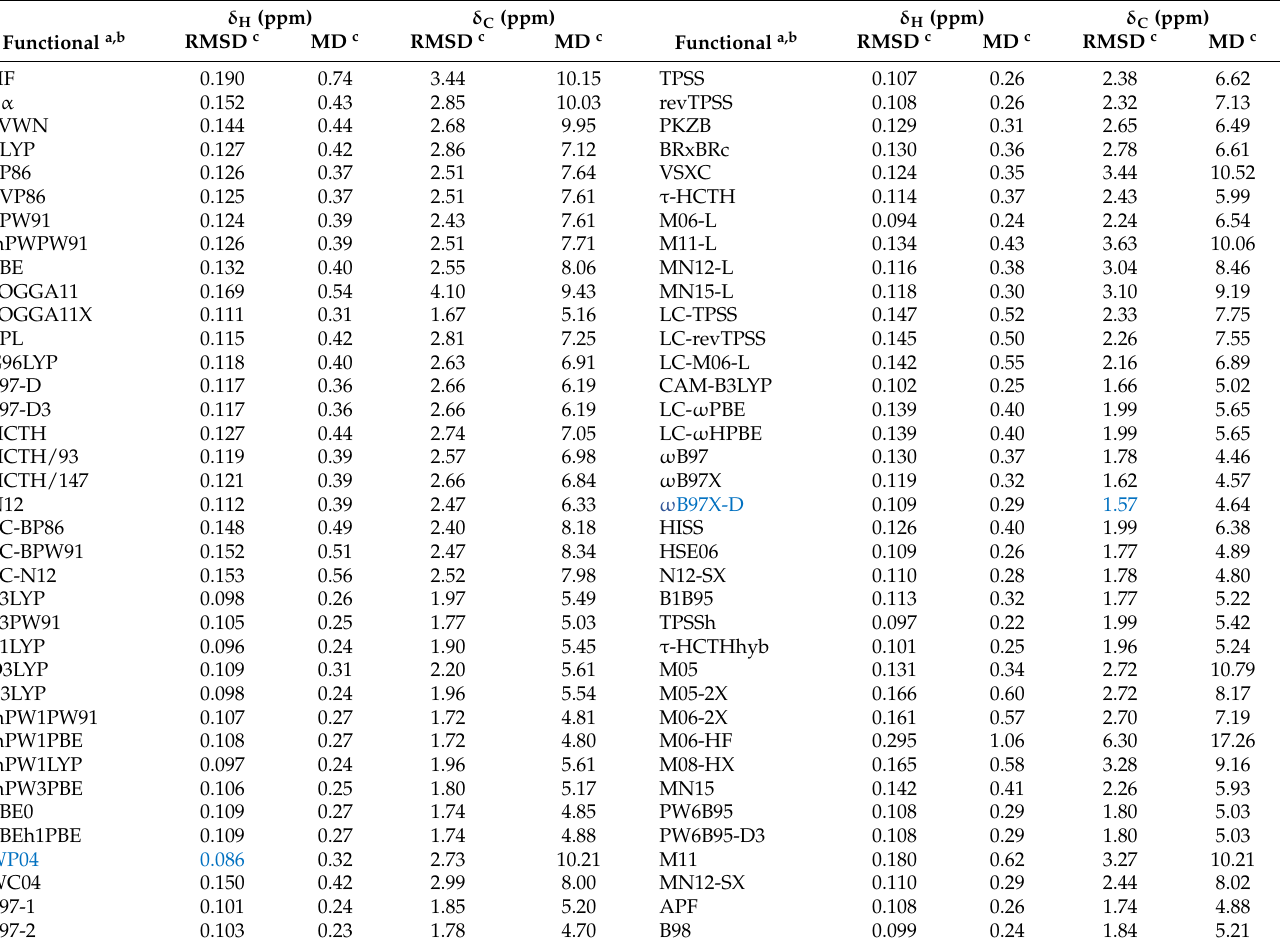
Table 2. Performance of density functionals and HF for 1 H and 13 C chemical shift